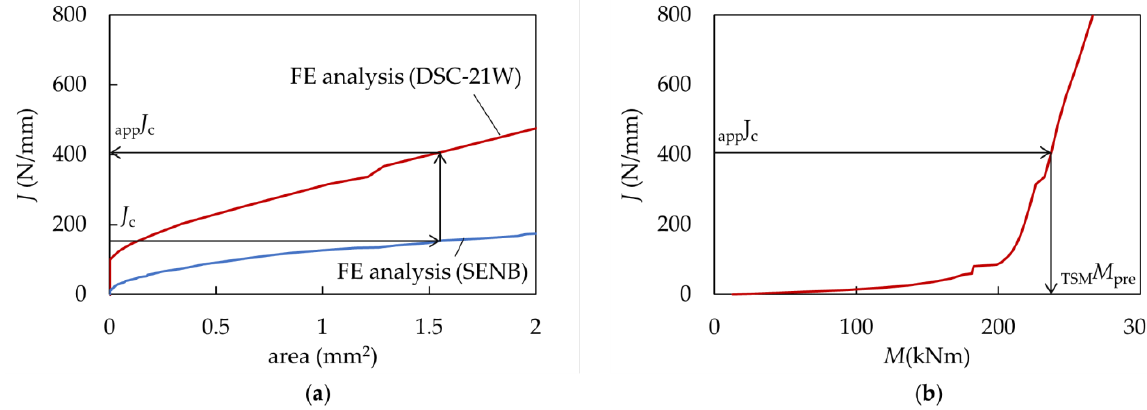
Figure 11. Failure moment prediction using TSM: ( a ) J-integral vs. area curves and ( b ) J-integral vs. moment curves.